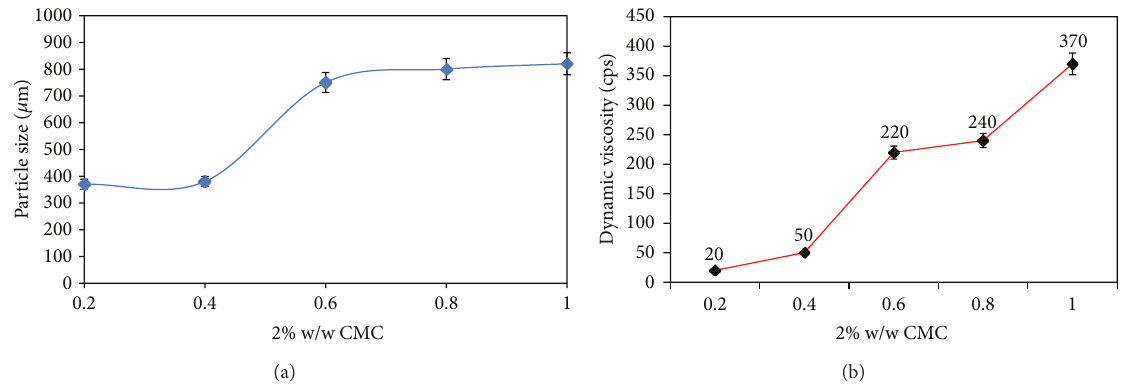
Figure 5: Effect of CMC on (a) particle size and (b) dynamic viscosity of SA/CMC blend crosslinked with Ca 2+ .